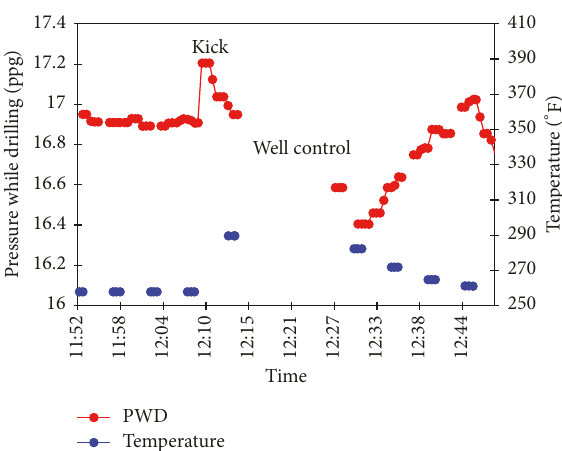
Figure 7: Well influx/kick detected from pressure while drilling showing an abrupt increase in measured downhole pressure (PWD or ECD) and